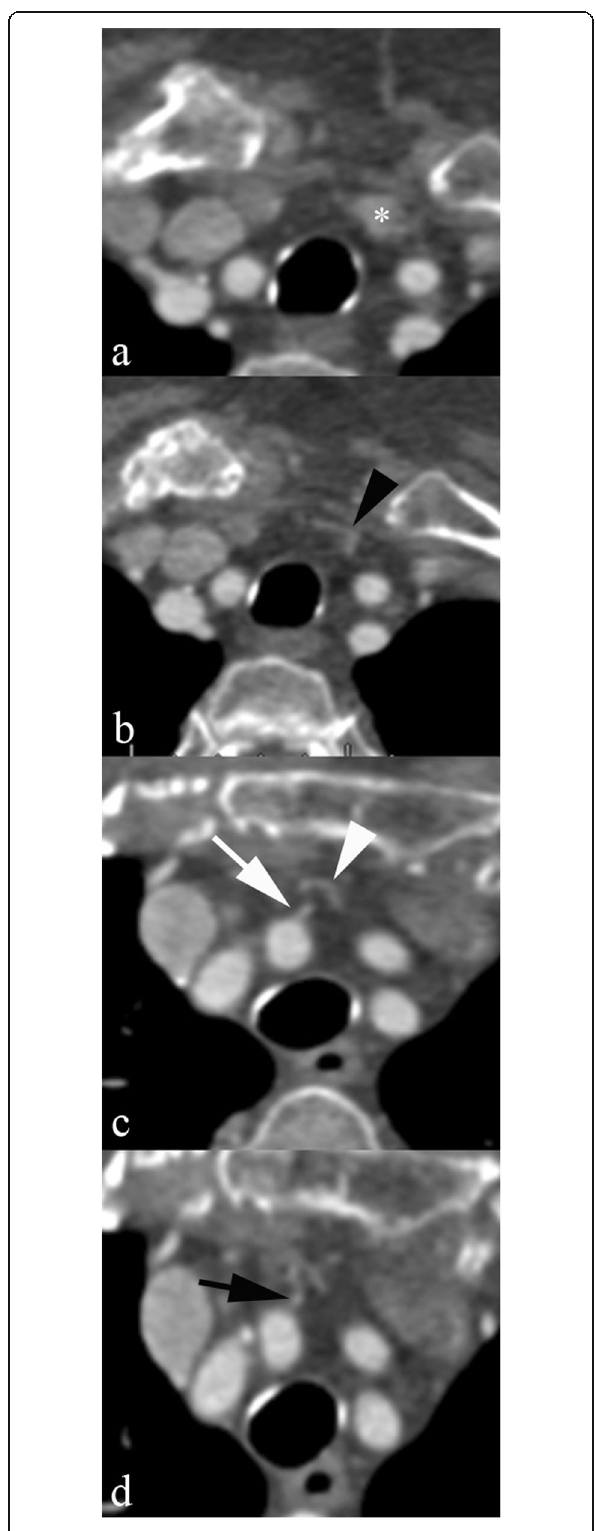
Fig. 10 Thyroid ima artery. Axial CT scan: a thin artery arises from the right common carotid artery (arrow in c ), bends inferiorly (arrow in d ) and then turns upwards (arrowheads in b and c ) to reach the lower pole of the left thyroid gland lobe (asterisk in a